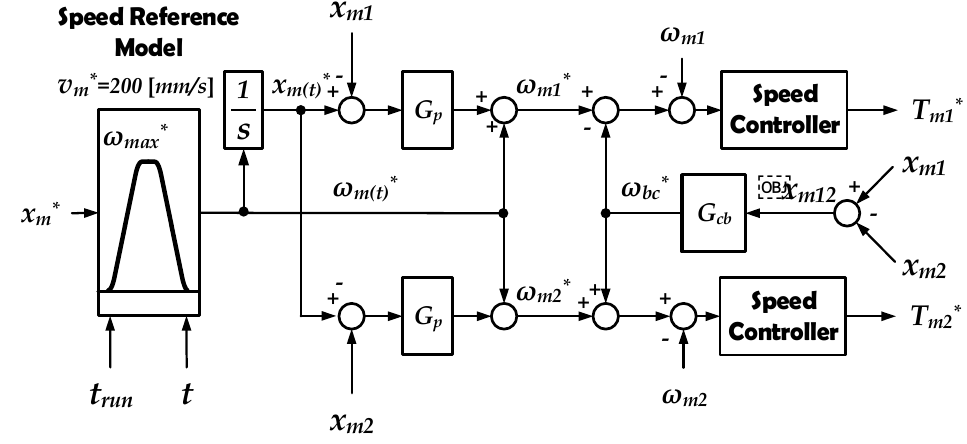
Figure 9. Simple balancing compensation control scheme.